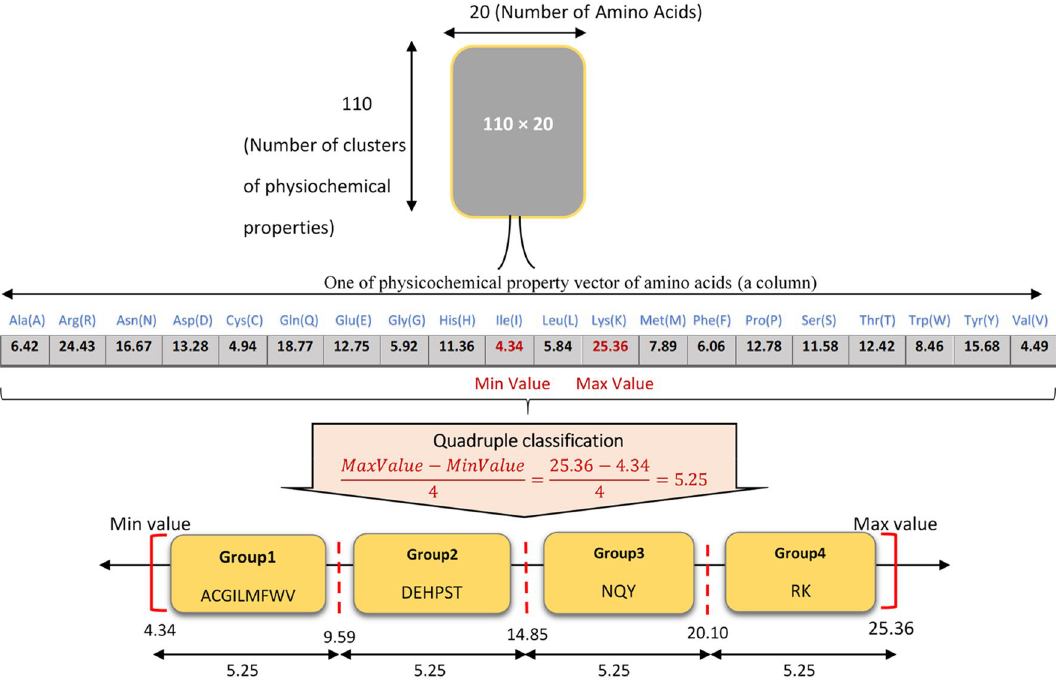
Figure 2. An example of categorizing a sample class into four groups of amino acids.